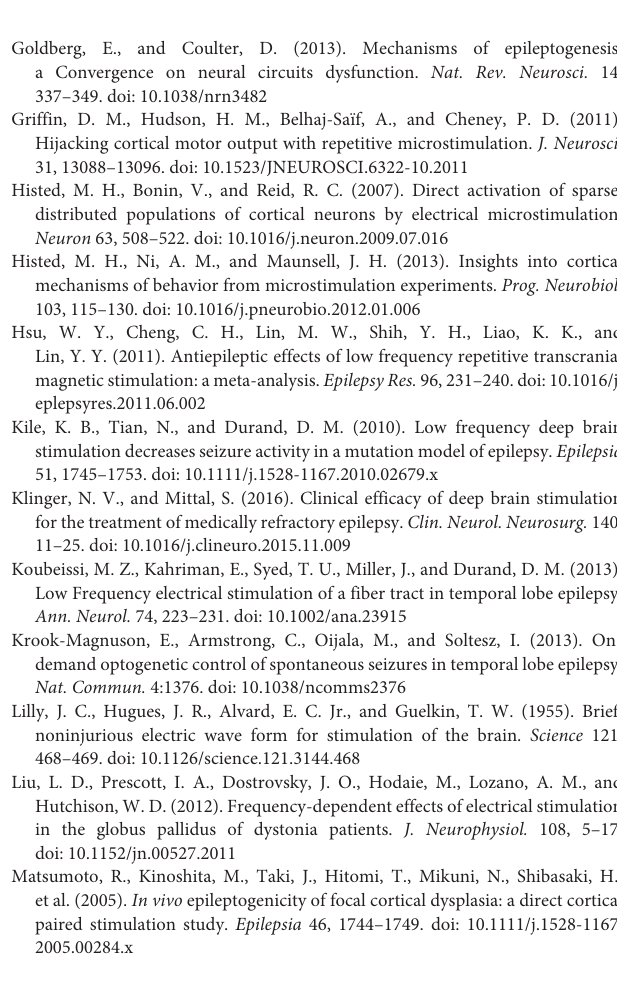
FIGURE S1 | Preoperative high-resolution MRI fused with postoperative